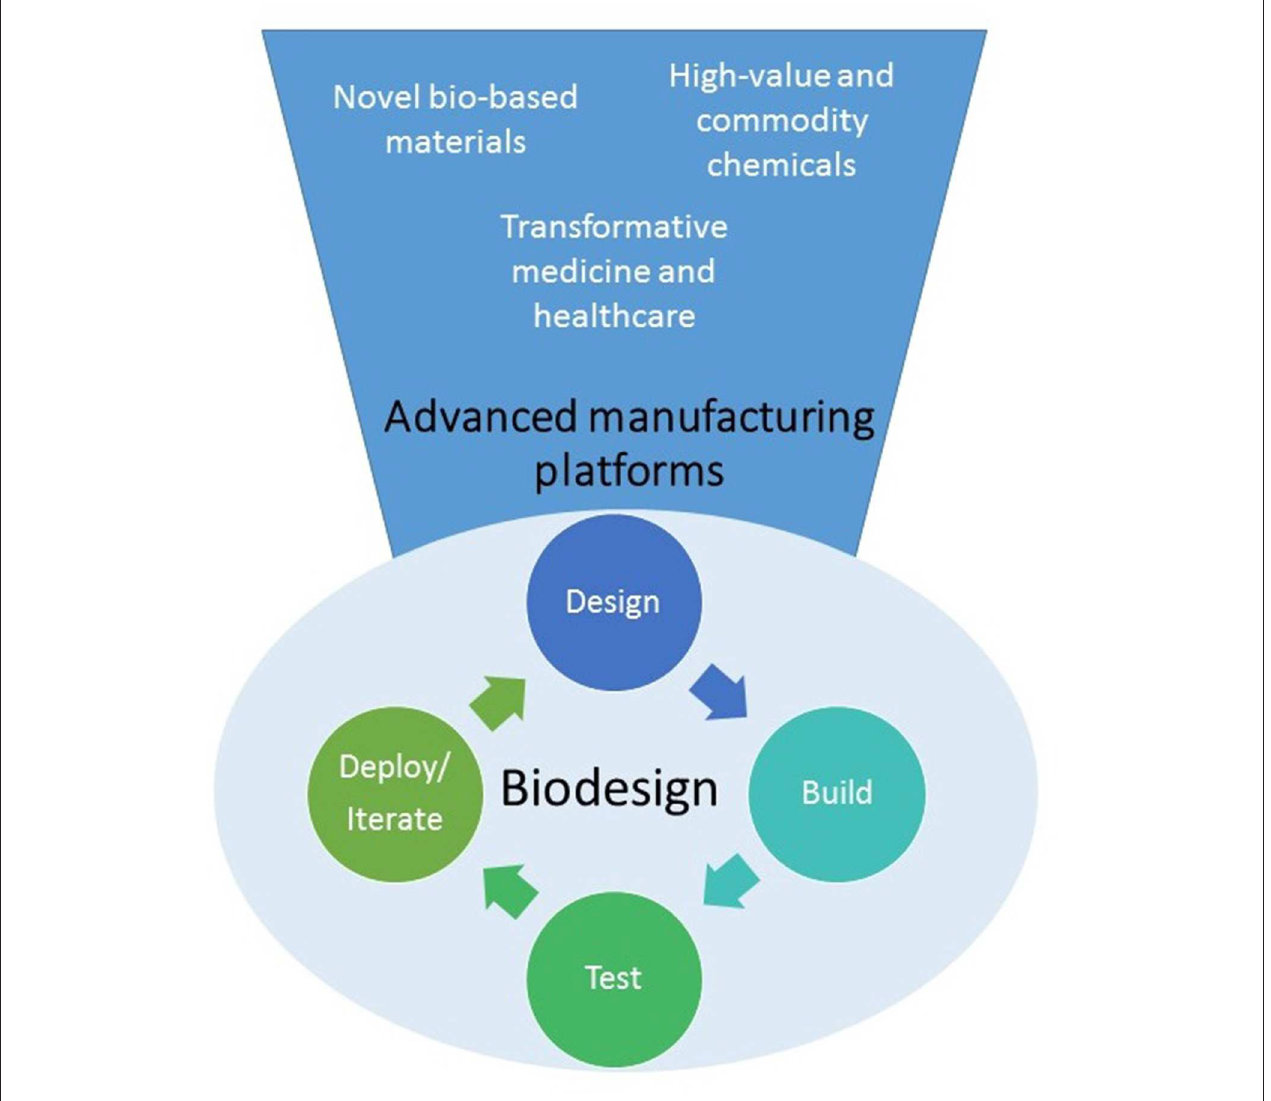
FIGURE 1 | Synthetic biology is developing into a biodesign platform where it will be possible to apply the “design-build-test-iterate (or deploy)” to predictably create cells or organisms able to produce a wide variety of novel molecules, materials or even cells for multiple